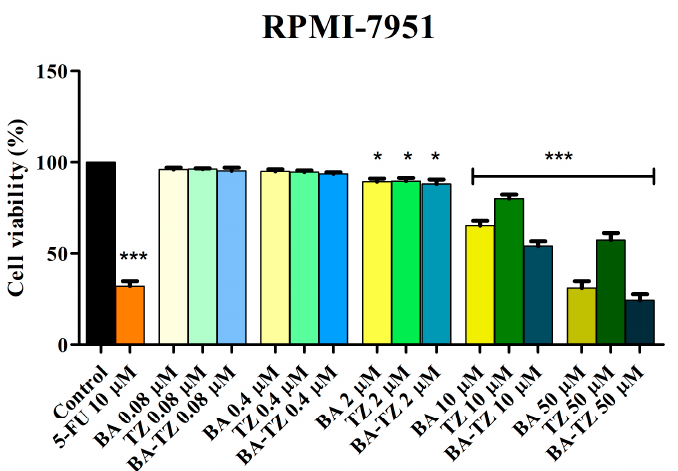
Figure 3. Cell viability of RPMI-7951 cells after 24 h treatment with BA-TZ 0.08, 0.4, 2, 10 and 50 µ M, determined using the MTT assay. Untreated cells were used as negative control, while 5-FU was used as positive control. The results are expressed as cell viability percentage (%) normalized to the negative control (100%). The data represent the mean values ± SD of three independent experiments performed in triplicate. The statistical differences vs. the negative control was determined using two-way ANOVA analysis followed by Bonferroni’s multiple comparisons post-test (* p < 0.05 and *** p <